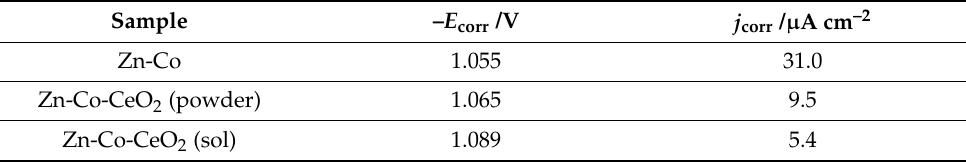
Table 3. The values of corrosion potential, E corr , and corrosion current density, j corr , for different coatings in 3%